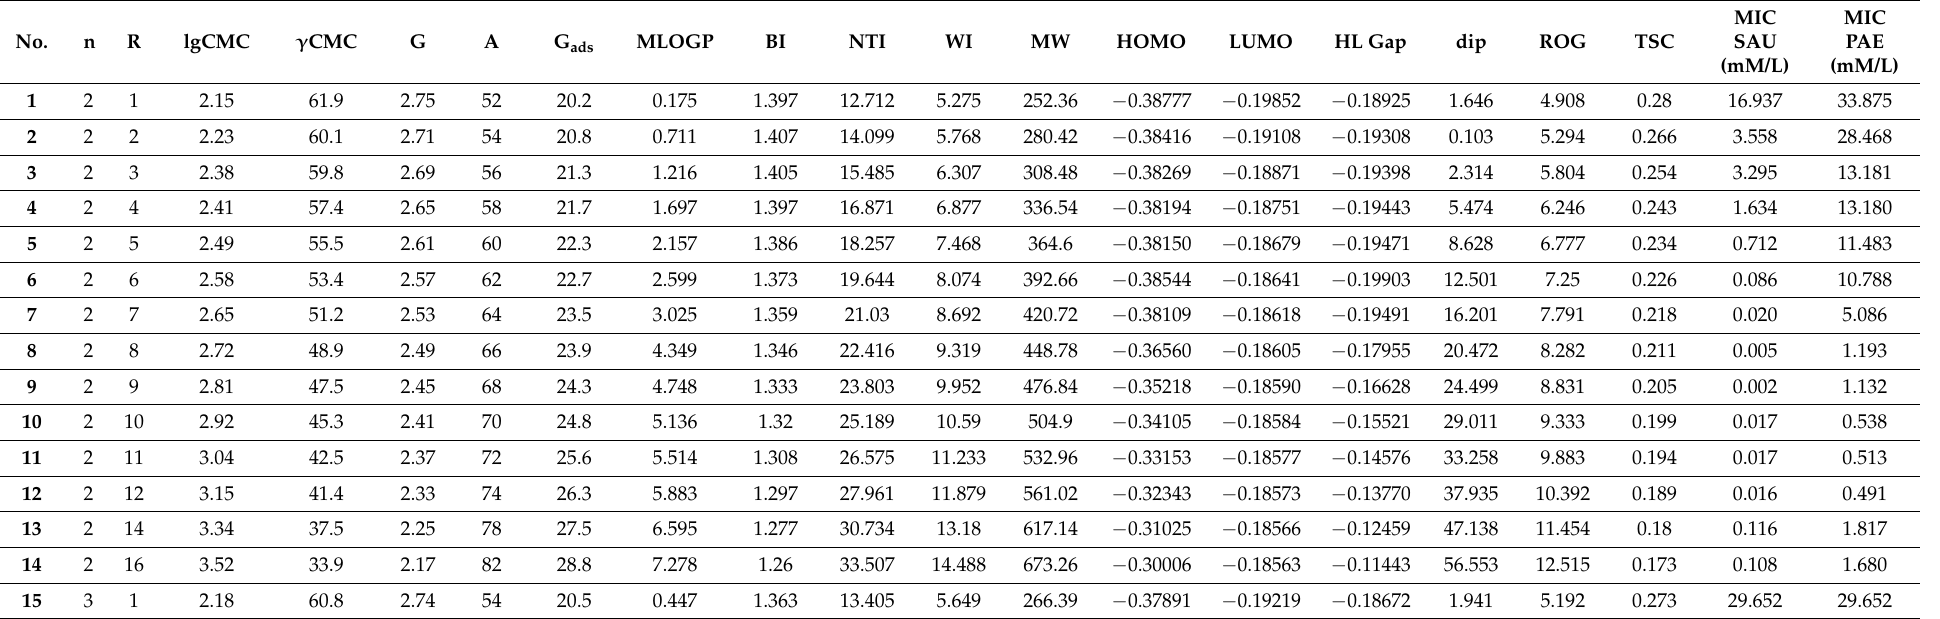
Table 5. A part of the information system (15 from 140